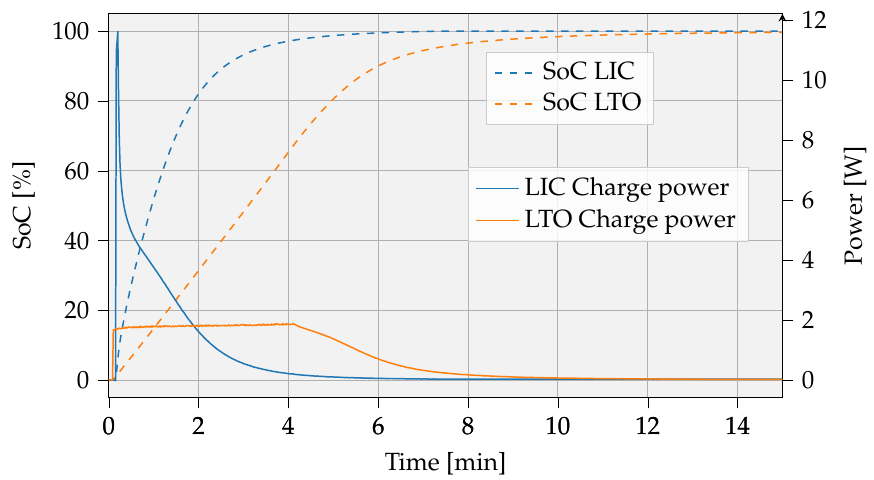
Figure 11. Measured charge curve of a 66.3mAh LTO battery and a 50F LIC